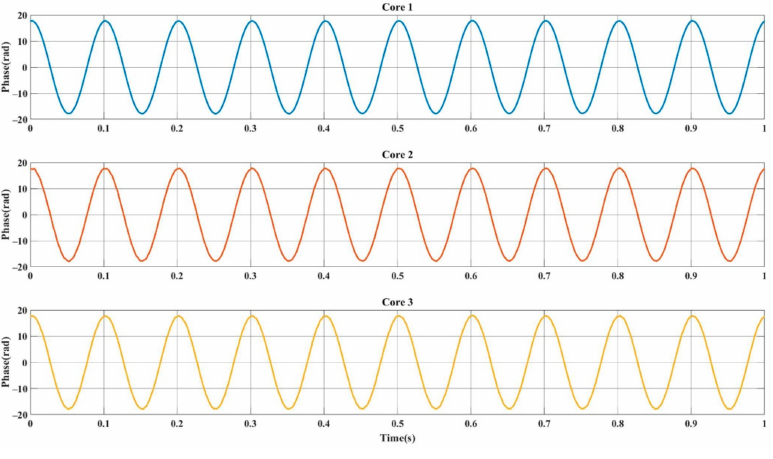
Figure 6. The result of three independent fiber